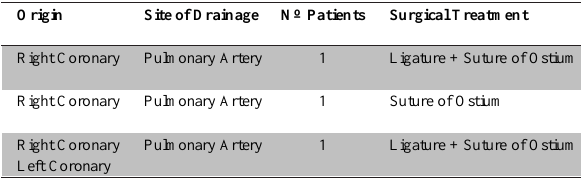
Table 2. Origin – site of drainage and adopted procedure